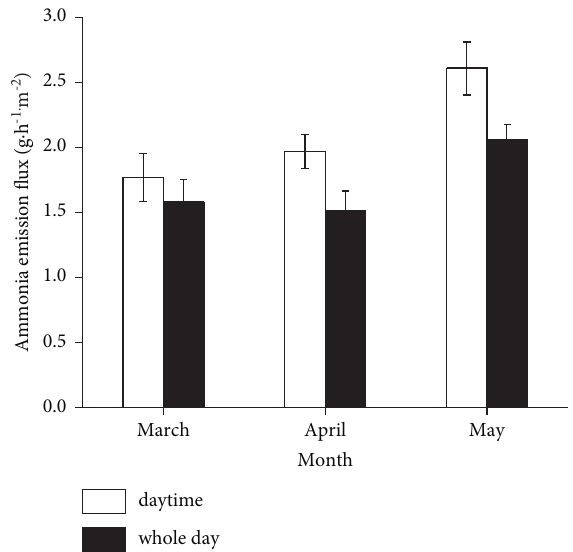
Figure 5: The emission rate of ammonia in different months.